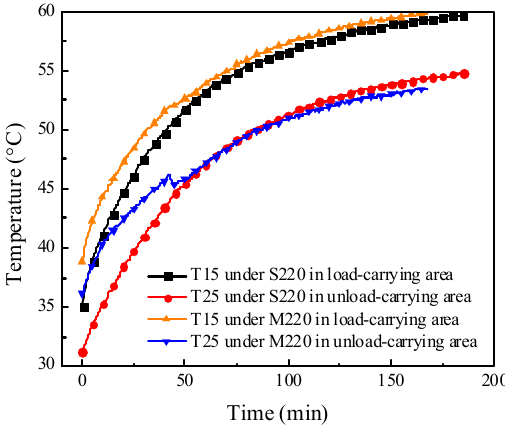
Figure 4. The oil ‐ film temperature variation with time at 200 rpm ‐ 6 MPa.